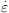
Values of time constant (τ
1) and residual stress ratio (G
∞) at three strain rates (ε˙).A: Overall, the time constants are significantly smaller under faster strain rates, while there is no systematic trend in the change of residual stress ratio. The boxes range from the lower quartile to upper quartile, the centerlines denote the medians, the whiskers denote extreme values and crosses denote outliers. B-D: Detailed views of the distributions of time constants and residual stress ratios from all data points at B: strain rate 0.06 s−1, n = 54; C: strain rate 3.54 s−1, n = 44; D: strain rate 22.88 s−1, n = 54.